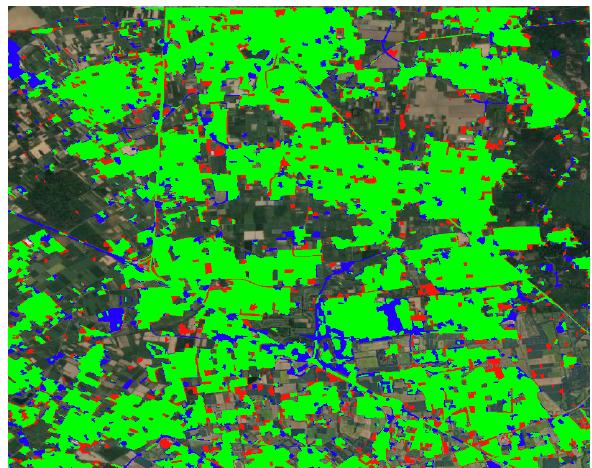
Figure 7: Urban classification results. Green: urban pixels de- tected both by the method and the ground truth, Red: urban pix- els detected only by the proposed method, Blue: urban pixels detected only by ground truth.